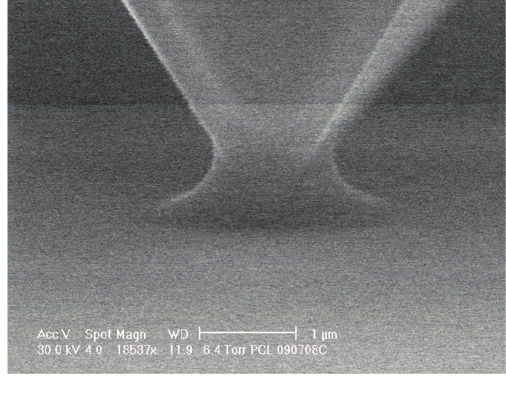
Figure 21. Electron microscope image of meniscus at an AFM probe tip. The radius